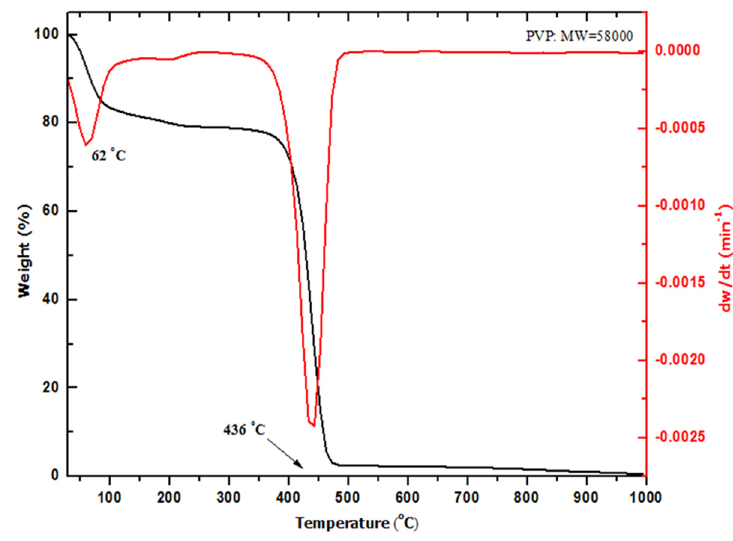
Figure 1. Thermogravimetric (TG) and thermogravimetric derivative (DTG) curves for polyvinyl pyrrolidone (PVP) at a heating rate of 10 °C/min.